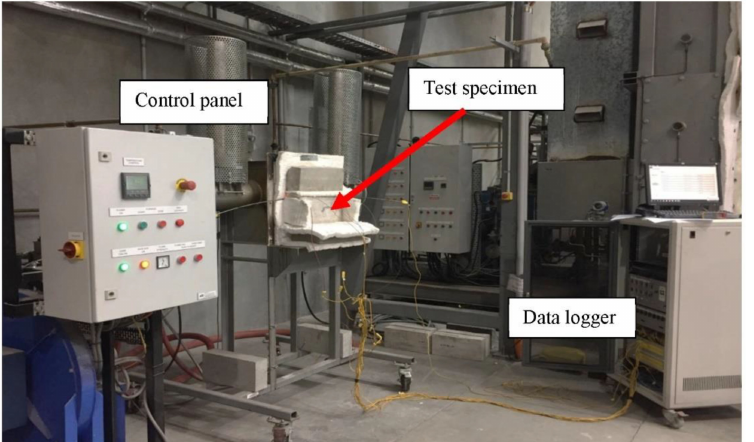
Figure 9. Fire test setup of masonry block.